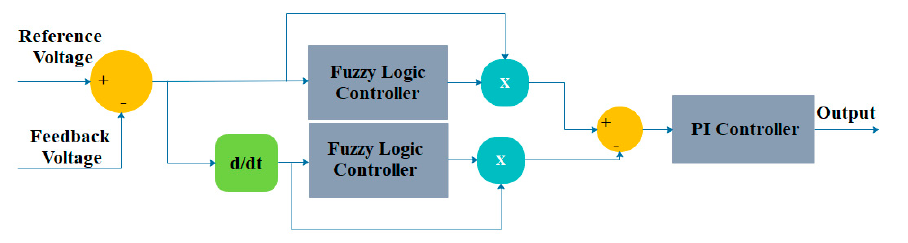
Figure 29. Voltage control block for proposed hybrid controller-2.